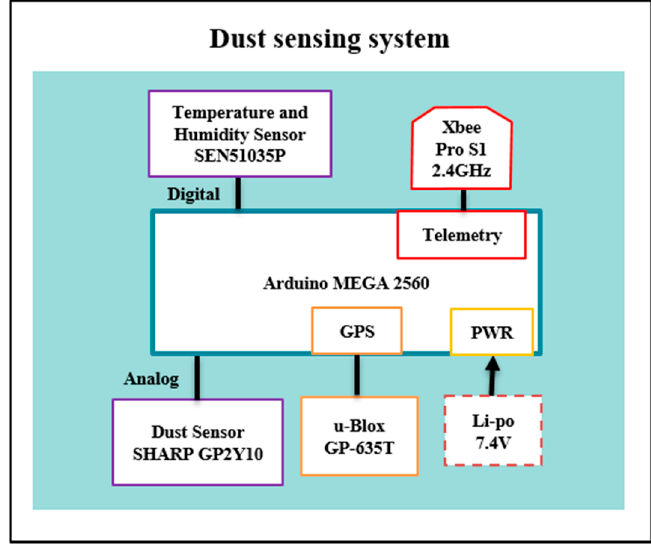
Figure 3. System architecture for the modular dust